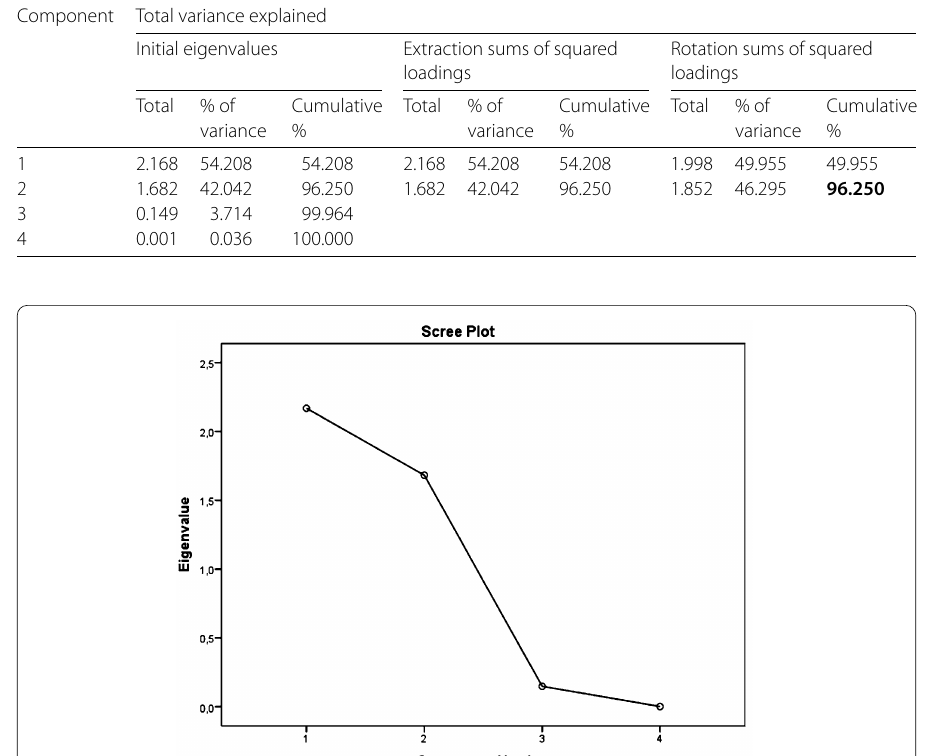
Table 7 The proportion of variance explained based on the eigenvalue statistics Component Total variance explained